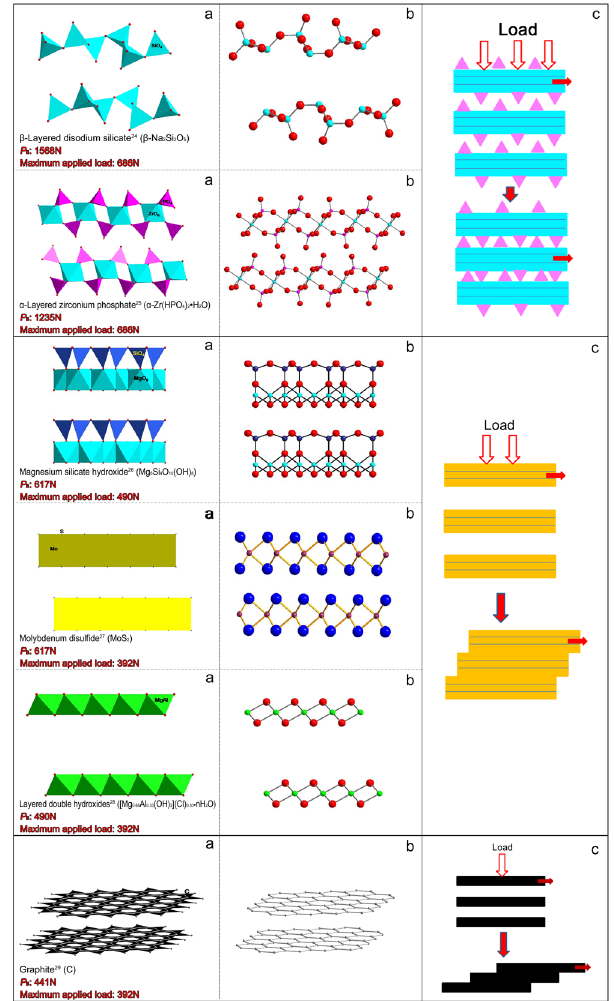
Figure 2. Summary of crystal structure data and load-carrying mechanisms for some typical layered materials. ( a ) Polyhedral conformation 24–29 . ( b ) Ball and stick model. ( c ) Load-carrying mechanism. Test conditions: P B : 25 °C, 1770 rpm, 10 s; Maximum applied load: 75 °C, 1200 rpm, 3600